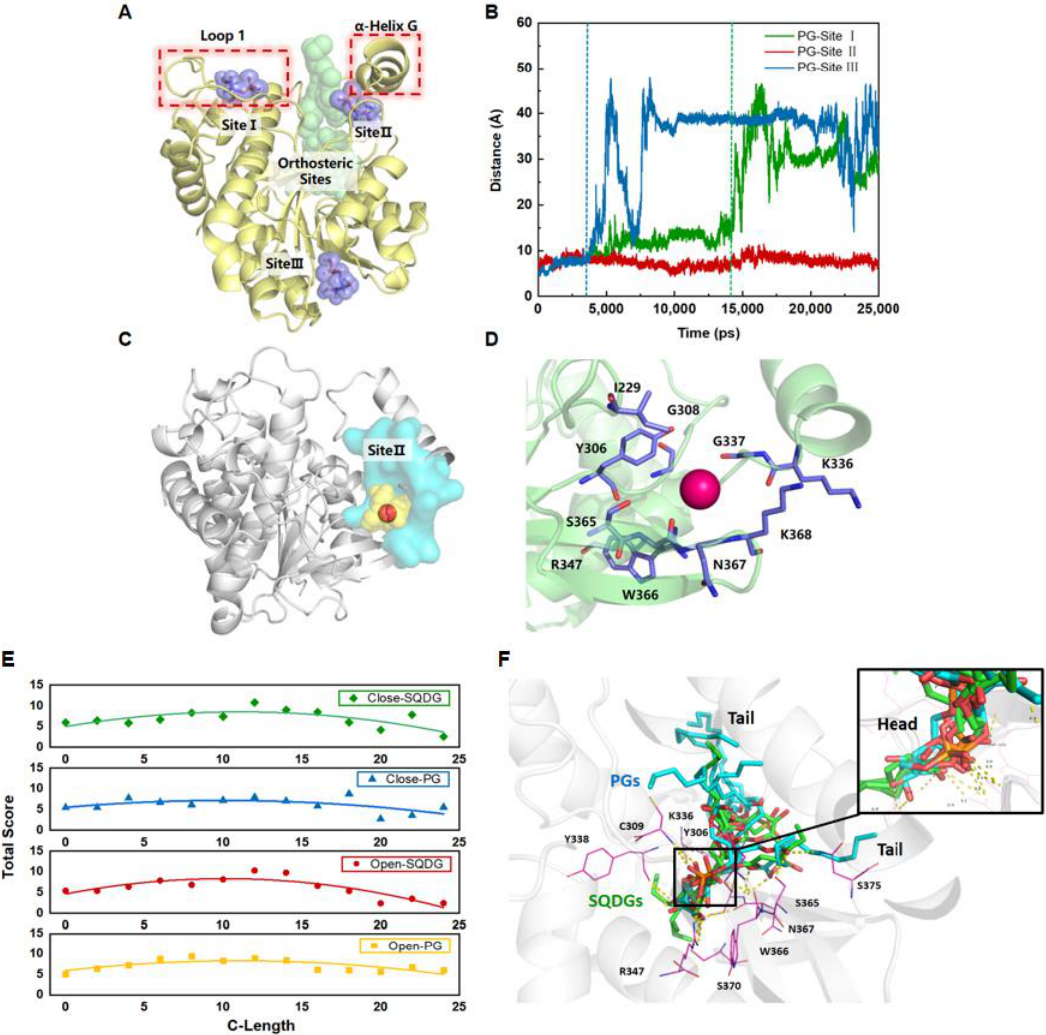
Figure 4. ( A ) The ternary complexes obtained by molecular docking with PGs in three potential allosteric pockets. ( B ) The distance between PG and sites I, II, and III in three unbiased molecular dynamics simulations. ( C ) The most-hit site II structure superposition. The purple ball represents the site identified by PARS, the cyan surface represents the site identified by Corrsite, and the yellow spheres represent the site identified by MOLCAD. ( D ) Amplification of site II with the key residues around. For clarity, the solvent and hydrogen atoms are not shown. ( E ) The docking scores for PGs and SQDGs to the open and closed LPOR conformations. The curves defined by dispersed coordinate points for the total score are approximated by second-order polynomial fitting. ( F ) The docking mode for PGs and SQDGs in LPOR in the open state. PGs and SQDGs are shown as cyan and green stick models, respectively, and LPOR is shown with silver cartoons. The dashed yellow lines represent hydrogen bond interactions between lipids and the neighboring residues (shown as magenta lines). The enlarged image in the upper right corner highlights the hydrophilic interaction between multiple lipid heads with LPOR protein.